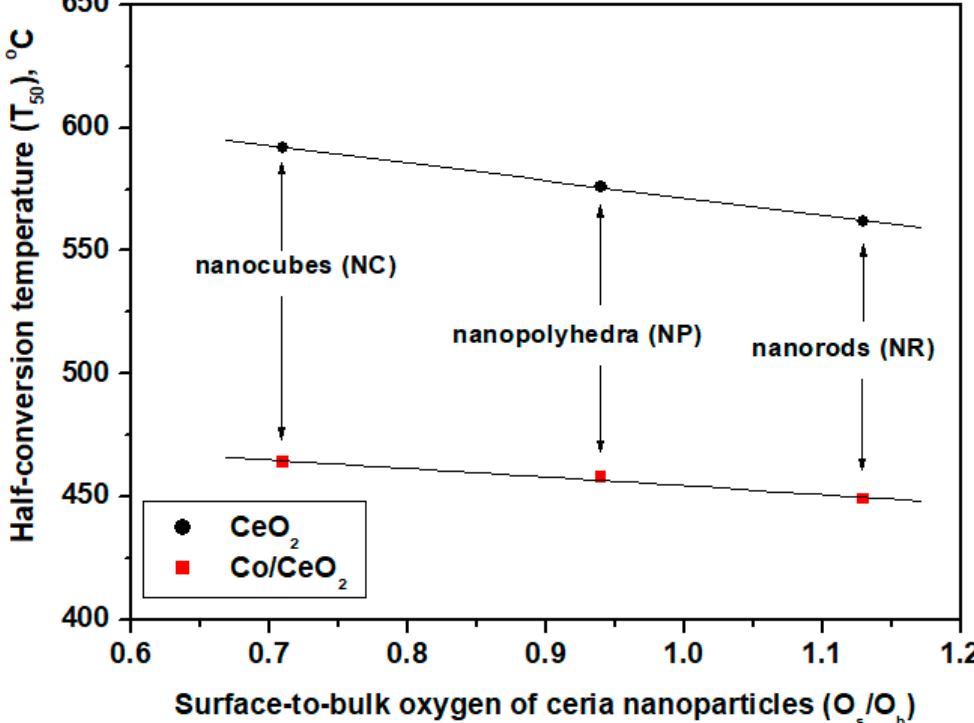
Figure 8. The half-conversion temperature (T 50 ) as a function of the TPR surface-to-bulk oxygen ratio (O s /O b ).